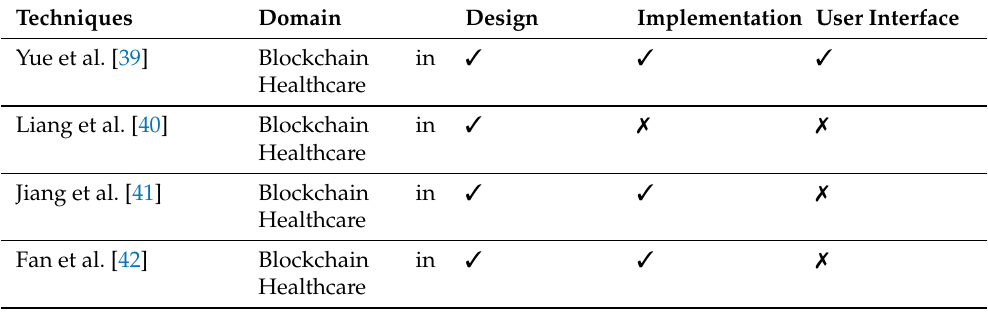
Table 1. Features-based comparison of the proposed framework with existing